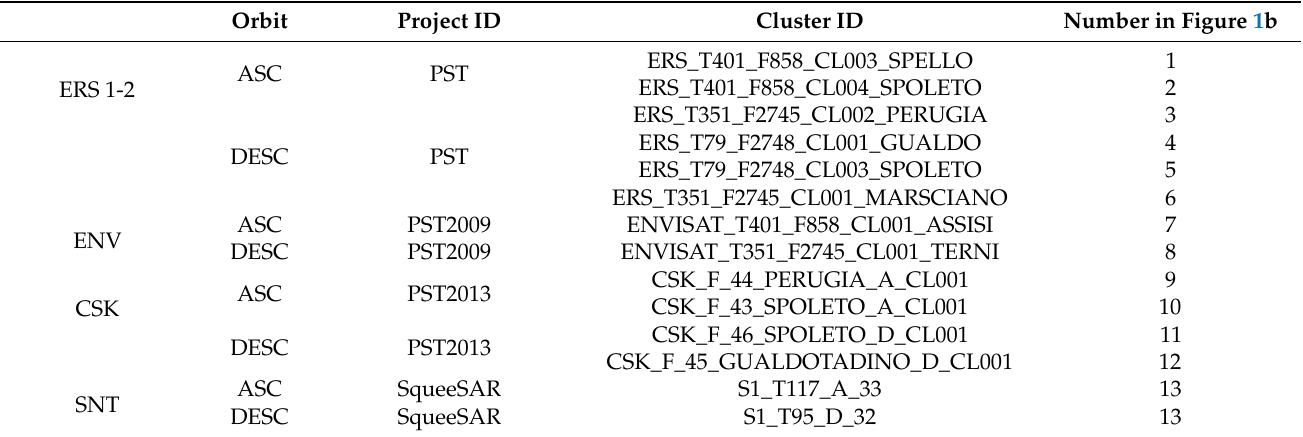
Table 3. The PS dataset includes the satellite missions, orbits, project identification code, project identification file name and list of PS clusters used for our analysis of the NUB area (see Figure